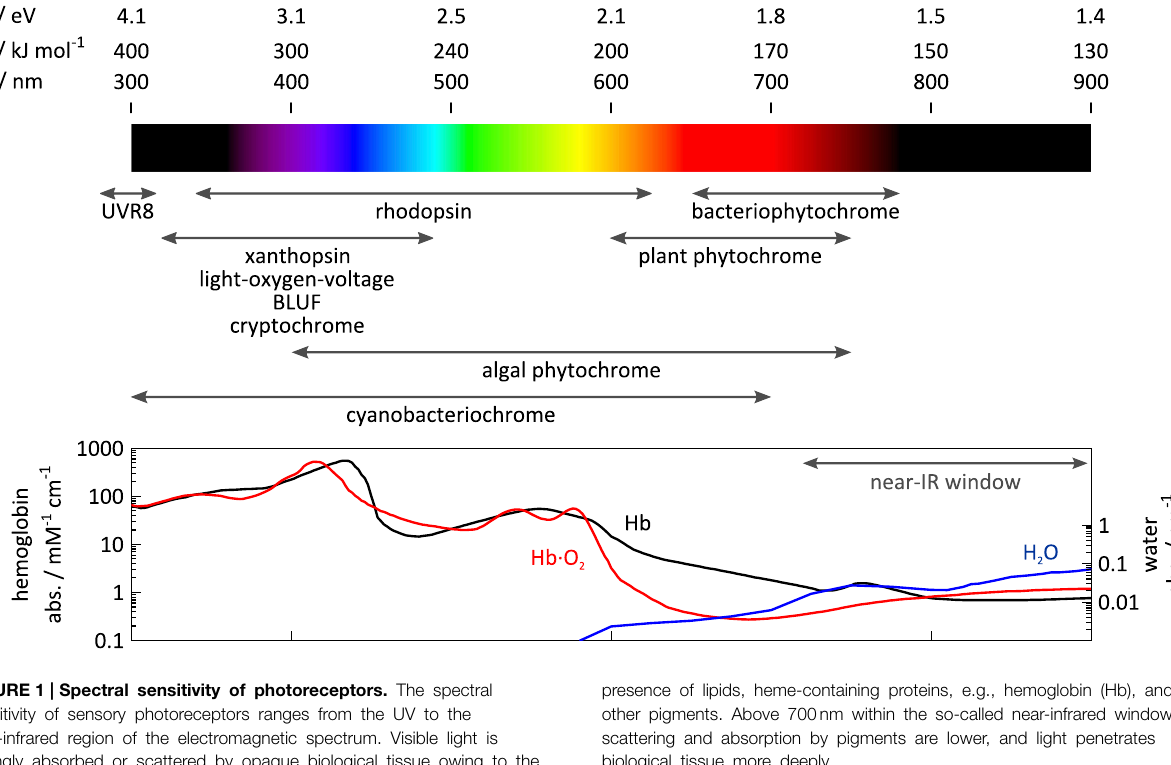
FIGURE 1 | Spectral sensitivity of photoreceptors. The spectral sensitivity of sensory photoreceptors ranges from the UV to the near-infrared region of the electromagnetic spectrum. Visible light is strongly absorbed or scattered by opaque biological tissue owing to the